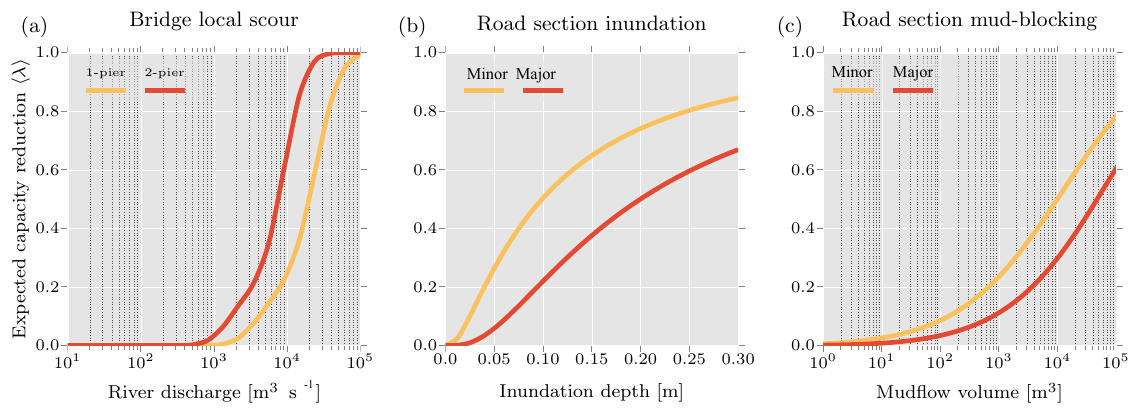
Figure 5. Functional loss functions for (a) bridge local scour, (b) road section inundation, and (c) road section mud-blocking. The horizontal axis represents the intensity measure (cid:52) of the corresponding hazard. For (a) bridge local scour and (c) road section mud-blocking the axes are displayed in log-scale. The vertical axis represents the expected functional loss. Table 4. Restoration costs and times for bridge local scour, road section inundation, and road section